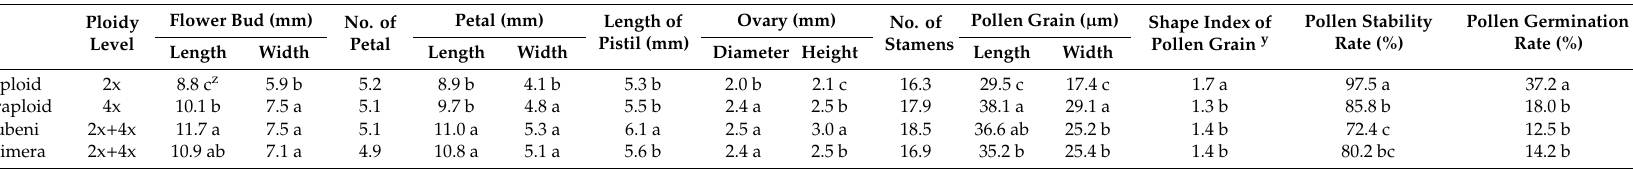
Table 4. Comparison of morphological characteristics of flowers and pollen grains in the diploid, the tetraploid, the Yubeni, and the chimera of the Meiwa kumquat. Flower Bud (mm) No. of Petal (mm) Length of Ovary (mm) No. of Pollen Grain ( µ m) Shape Index of Pollen Stability Pollen Germination Ploidy Pistil (mm) Rate (%) Rate (%) Length Width Length Width Diameter Height Length Width Level Petal Stamens Pollen Grain y Diploid 2x